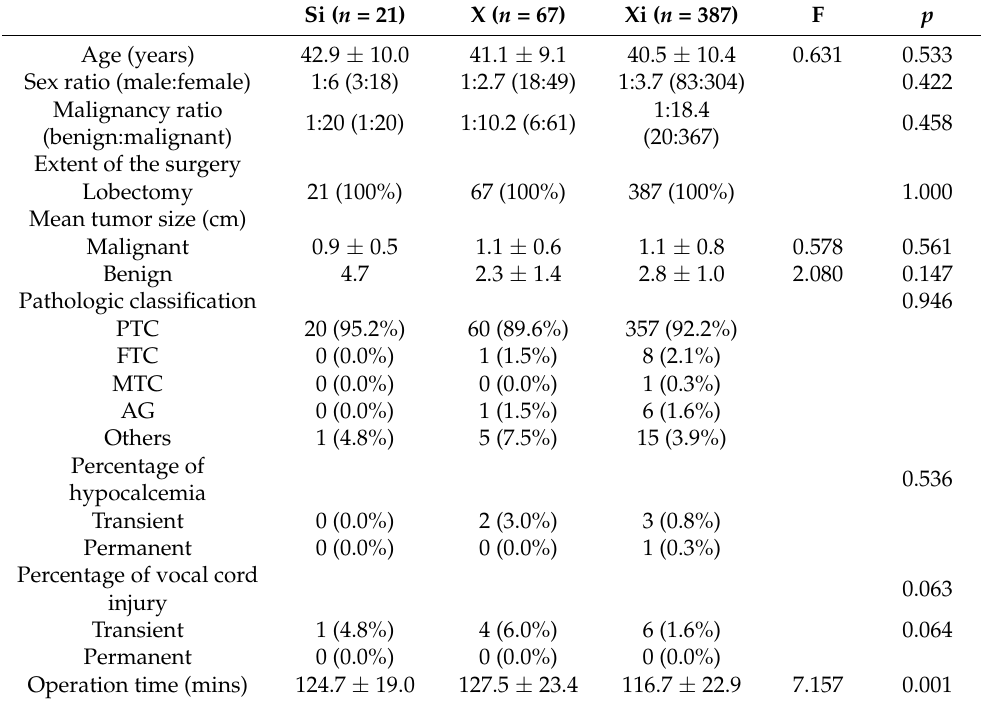
Table 3. Substudy B comparing da Vinci models Si, X, and